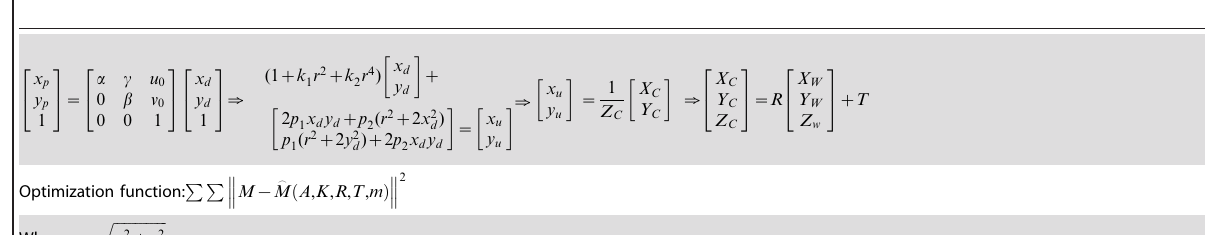
Table 2. The calibration model of the